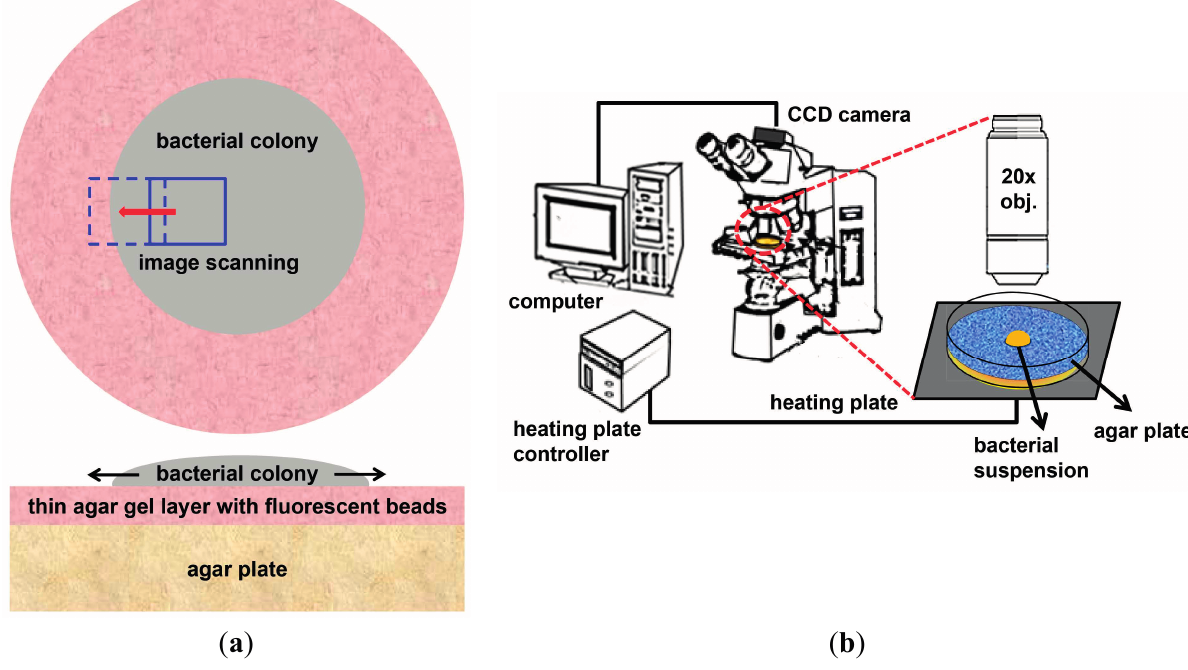
Figure 5. ( a ) Top and cross-sectional views of the bacterial colony growing on an agar plate, coated with a thin layer of 200 nm fluorescent microbeads; ( b ) Schematic of live cell imaging setup for visualization of fluid dynamics in swarm colony formed at the agar